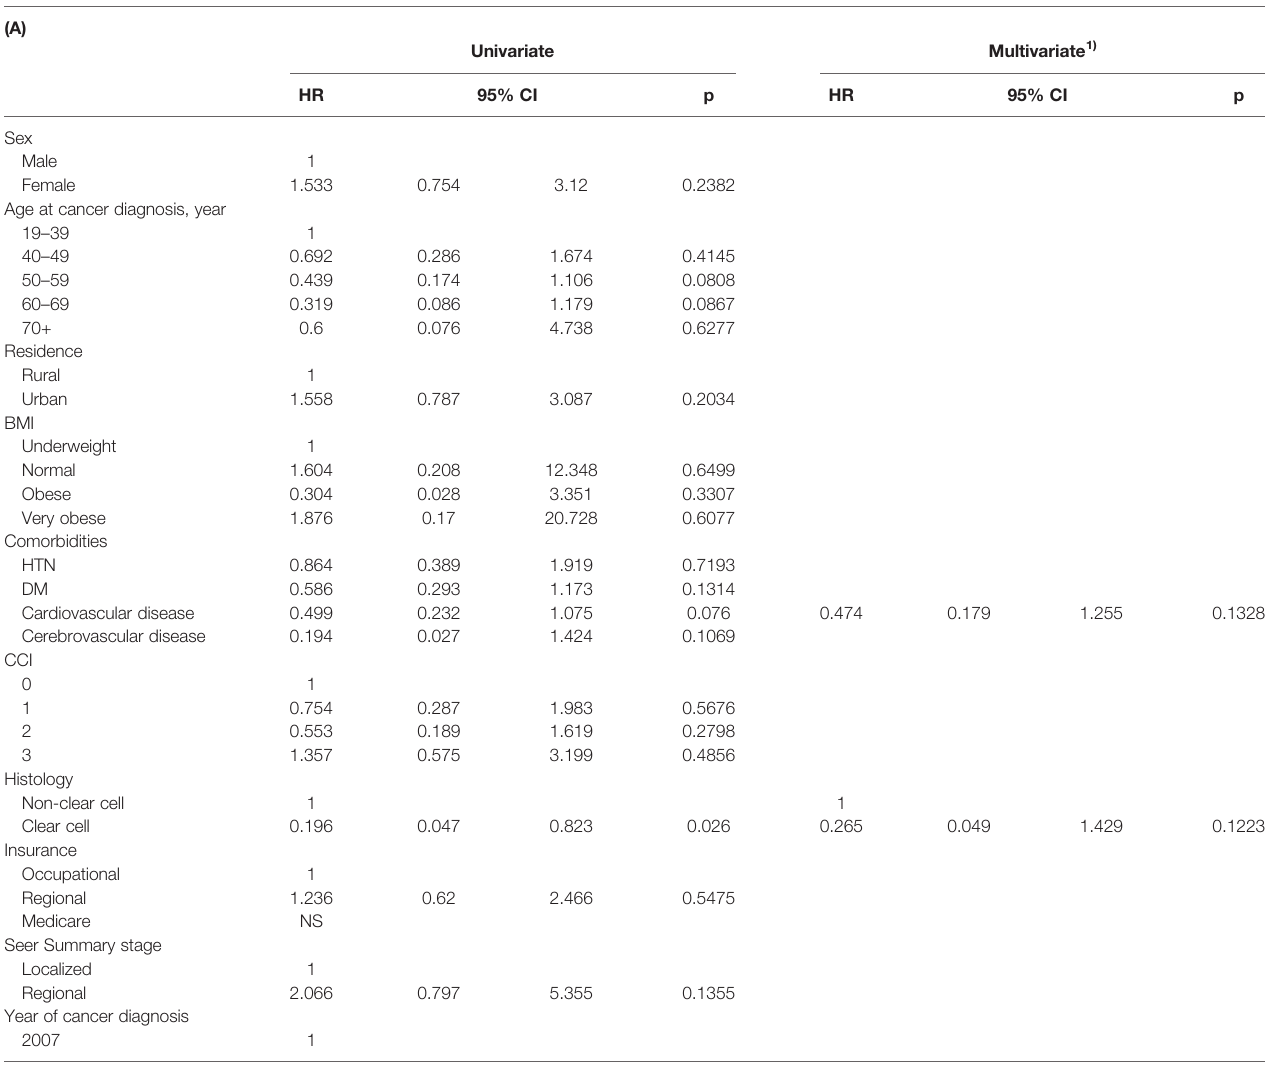
TABLE 6 | Multivariate analysis of cancer speci fi c survival in 1:1 PSM matched RCC patients between (A) OP and TT groups and (B) TT and OST groups with postoperative disease progression after